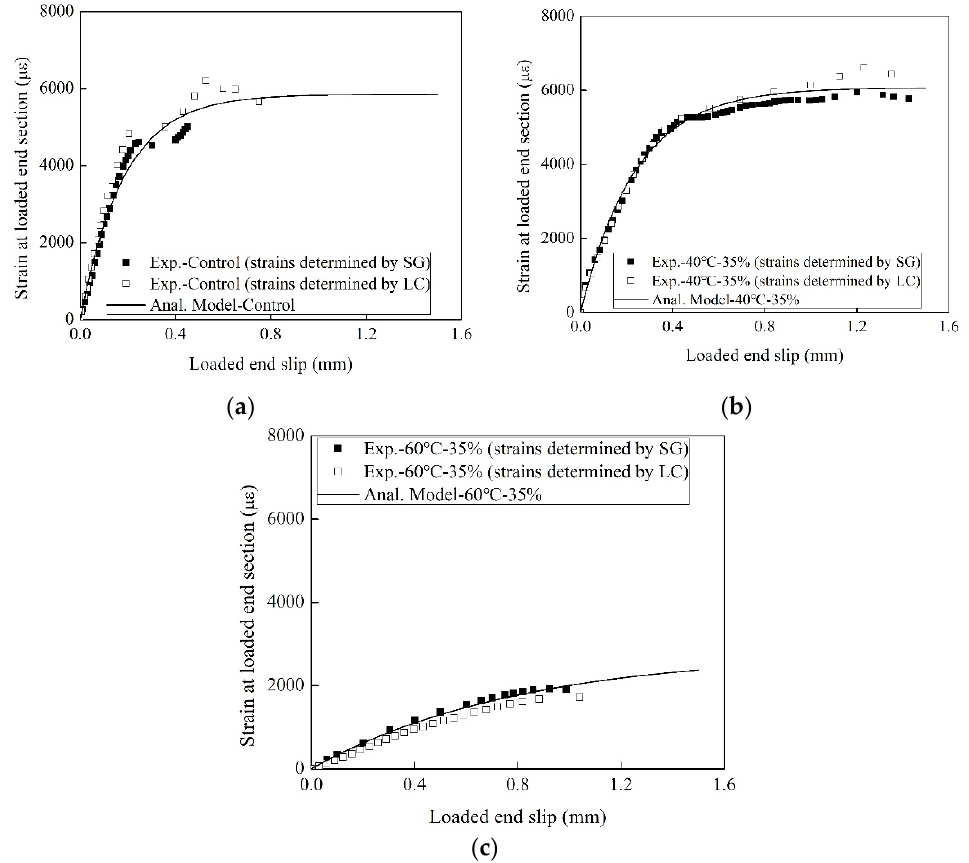
Figure 4. The typical measured strain–slip data and their corresponding regressed fitting curve at: ( a ) 15 °C; ( b ) 40 °C; ( c ) 60 °C.